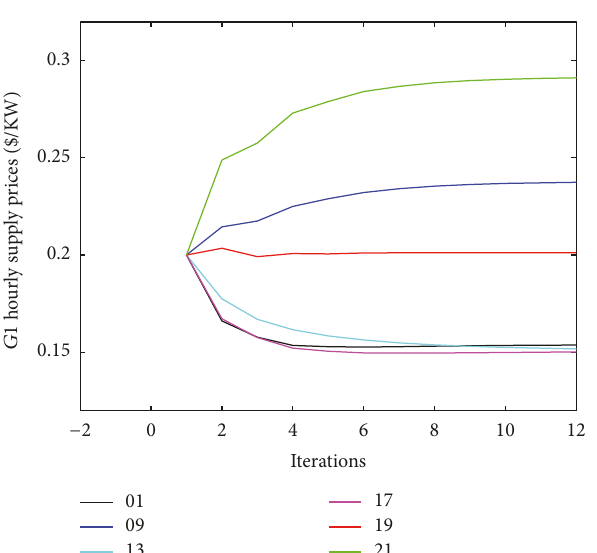
Figure 7: Partial hourly delivery prices trajectories of L 2.